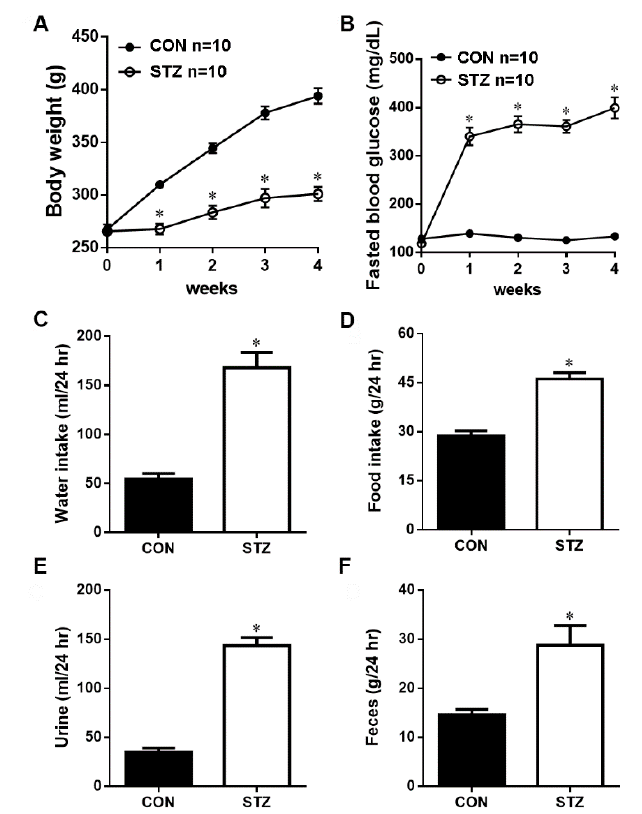
Figure 1. The basal physiologic parameter of body weight ( A ), fasted blood glucose ( B ), water intake ( C ), food intake ( D ), urine amount ( E ) and feces amount ( F ) in the control (CON) and streptozotocin-diabetic (STZ) rats. After 4 weeks of STZ induction, these physiological parameters are significantly increased as compared with CON rats. Data are expressed as mean ± SEM ( n = 10) using the single values. * p < 0.05 vs. CON.